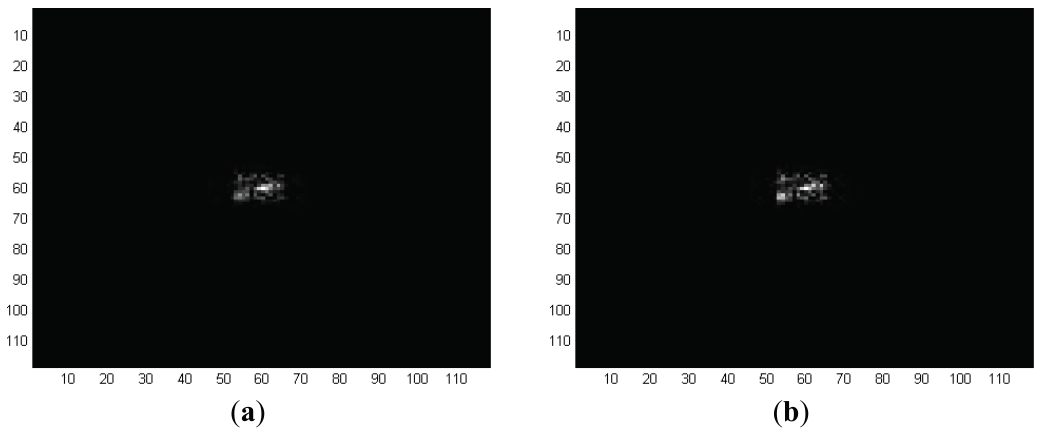
Figure 3. Spatial domain representation of Range-1 detection filters for the target (tank1) of Sequence L2018 ( a ) MACH filter; and ( b ) EMACH